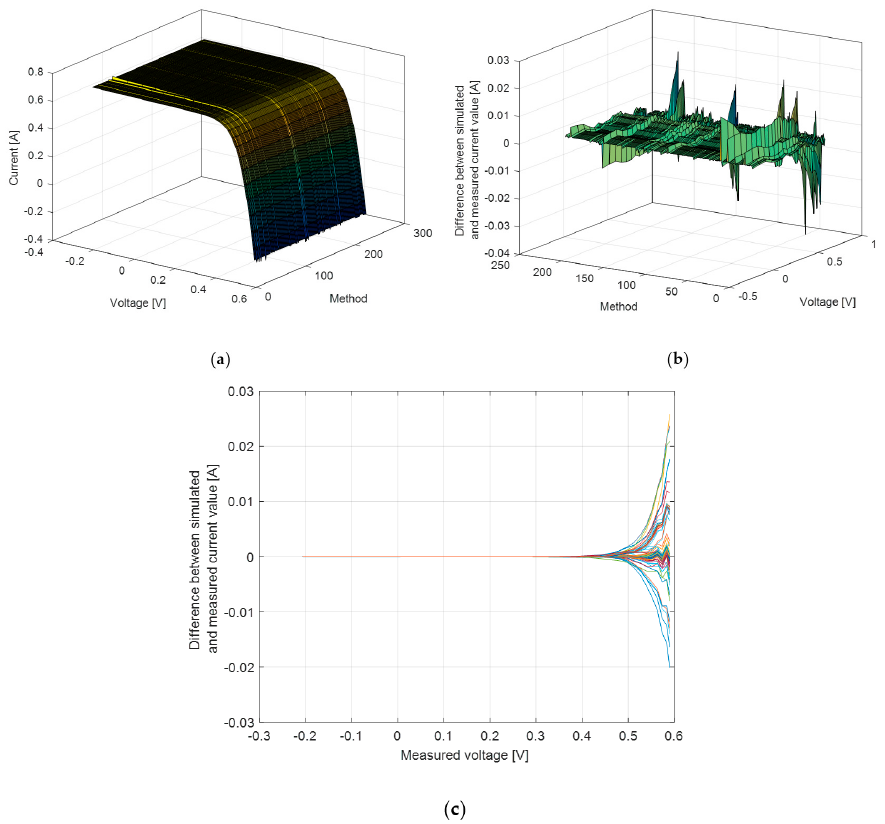
Figure 3. RTC France solar cell: ( a ) current-voltage characteristics; ( b ) the corresponding error; ( c ) error in the current values versus the measured voltage for all